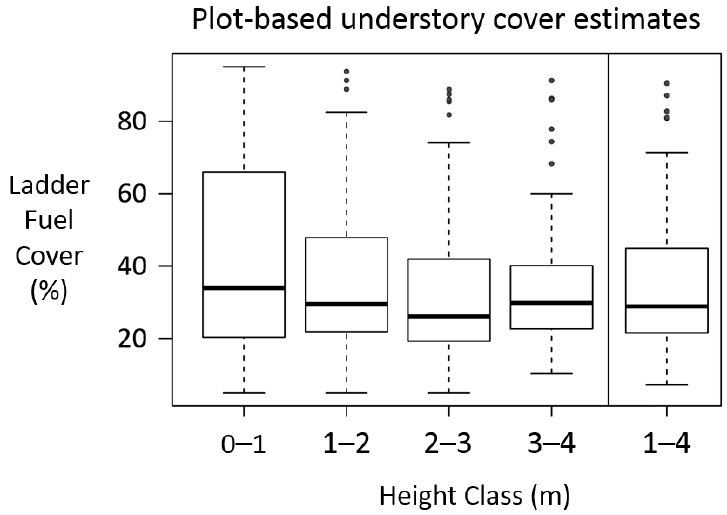
Figure 8. A box-and-whisker plot that displays the distribution of ladder fuel cover within each 1 m class across all plots is shown. We also include the average ladder fuel cover between 1 and 4 m in each plot.